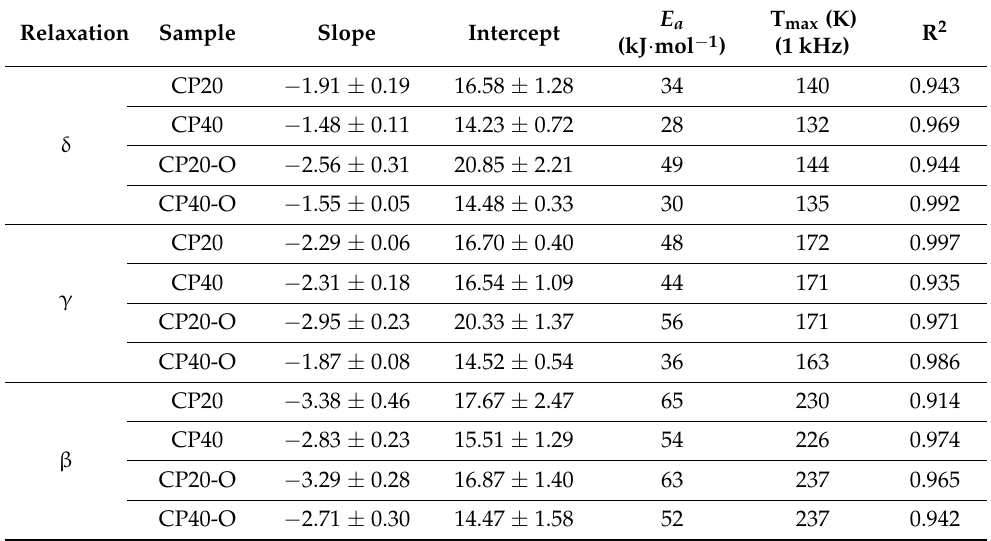
Table 3. The apparent activation energy ( E a ) and temperature peak for the modified oriented and unoriented copolymers.